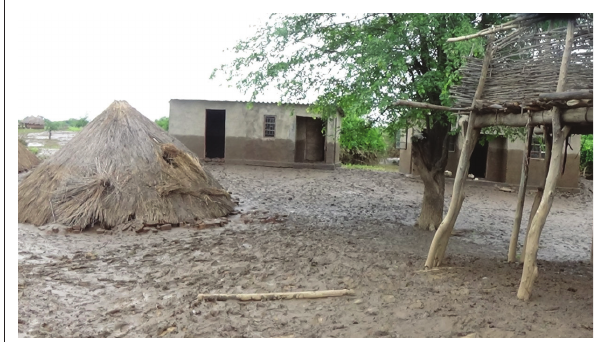
FIGURE 4: Destroyed weak mortared houses, intact cement-built houses and granaries on